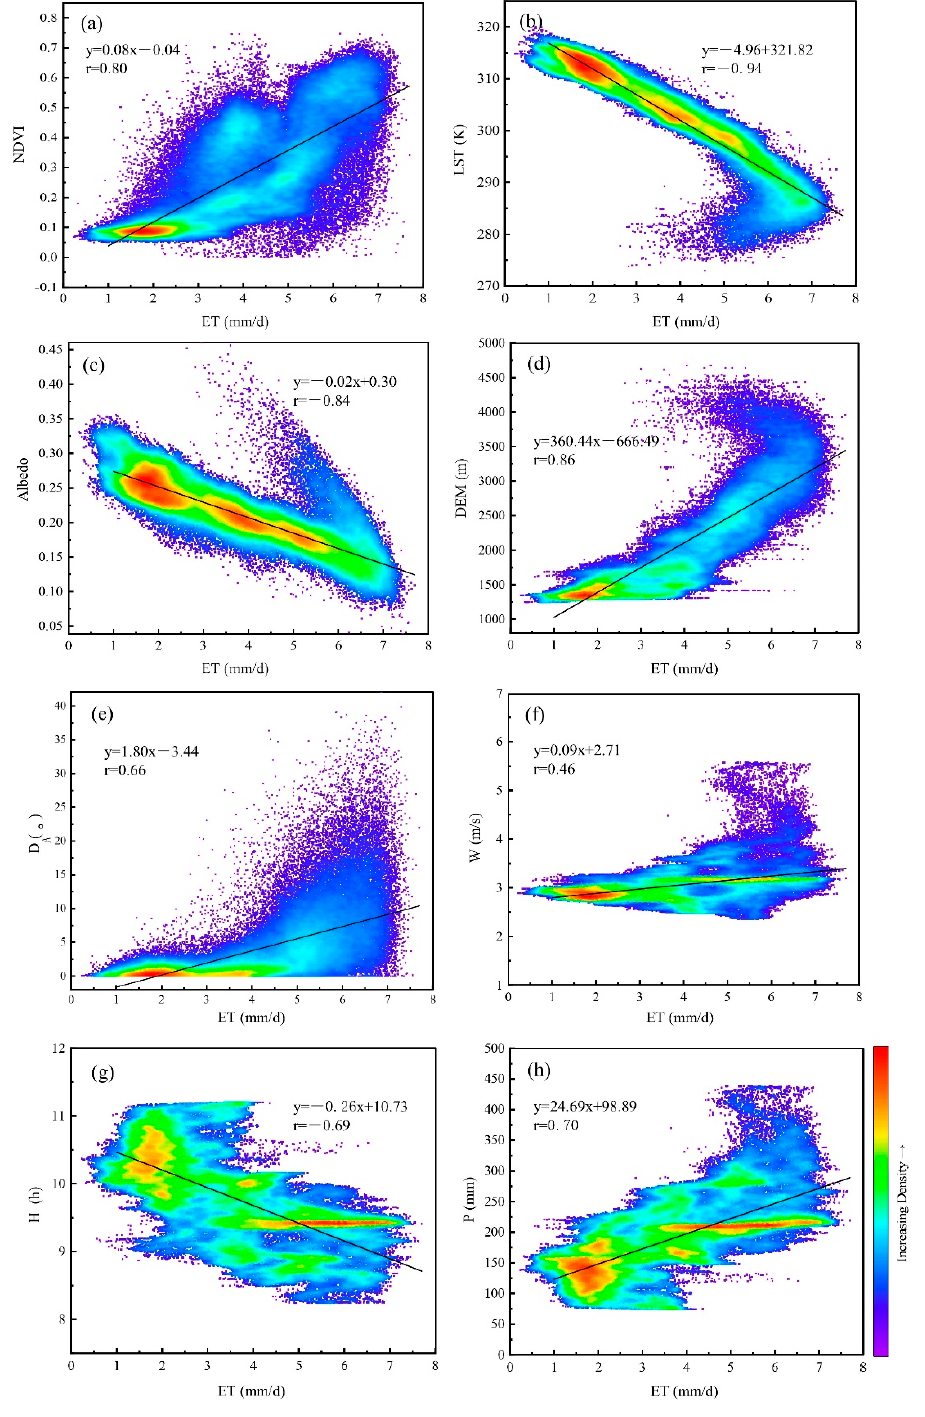
Figure 7. Correlation analysis diagram between ET and ( a ) NDVI, ( b ) LST, ( c ) albedo, ( d ) DEM, ( e ) D, ( f ) W, ( g ) H, and ( h ) P.